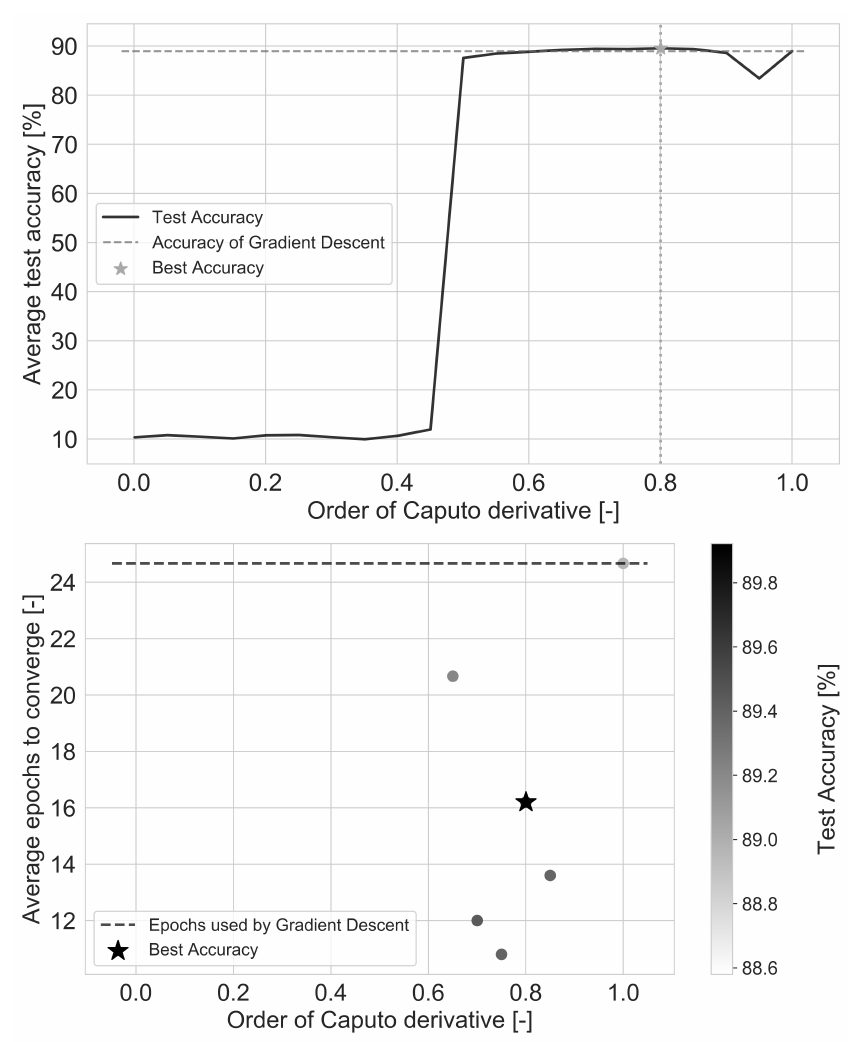
Figure 8. Average test accuracy, and the average training epochs taken to reach Gradient Descent’s accuracy (from top to bottom) on the MNIST